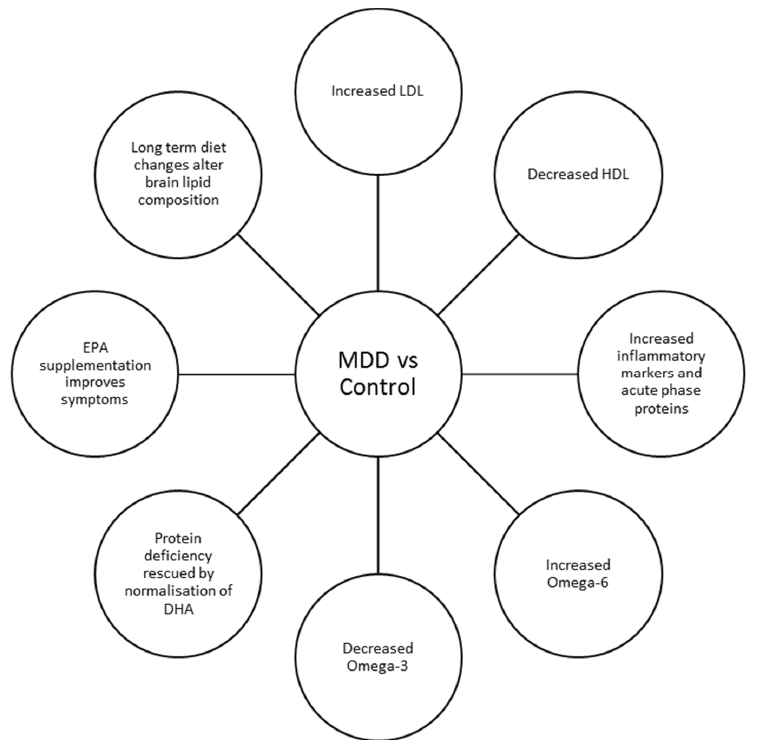
Figure 2. The role of lipids in major depression disorders (MDD). The various potential roles for lipids in the cellular pathophysiology underpinning MDD are shown in this diagram. The main findings when comparing MDD patient with controls is an altered lipid profile, most specifically that low-density lipoproteins (LDL) and omega-6 levels are raised, where high-density lipoproteins (HDL) and omega-3 levels are decreased. EPA: eicosapentaeonic acid; DHA: docosahexaenoic